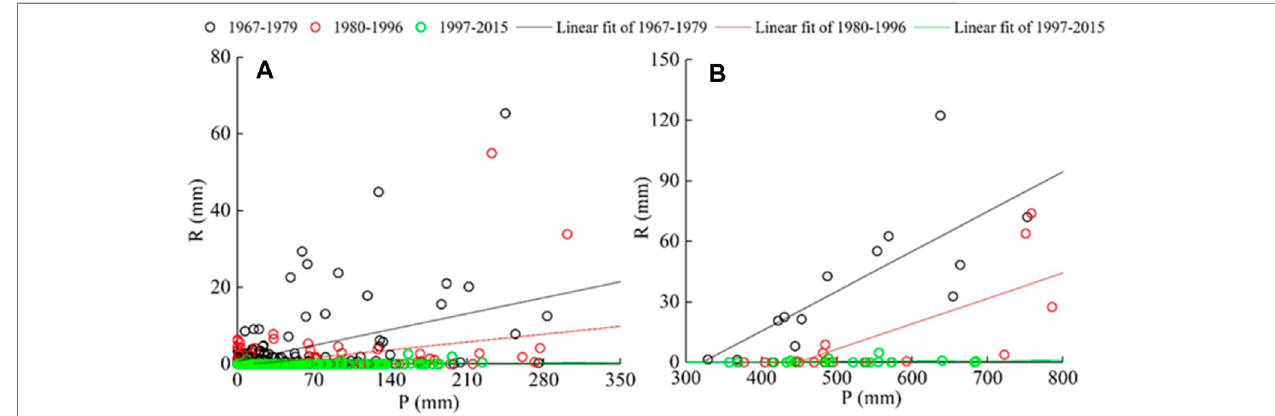
FIGURE 5 | Relationships between runoff and precipitation on monthly (A) and annual (B) scales of the Zhulong River catchment during 1967 – 2015.